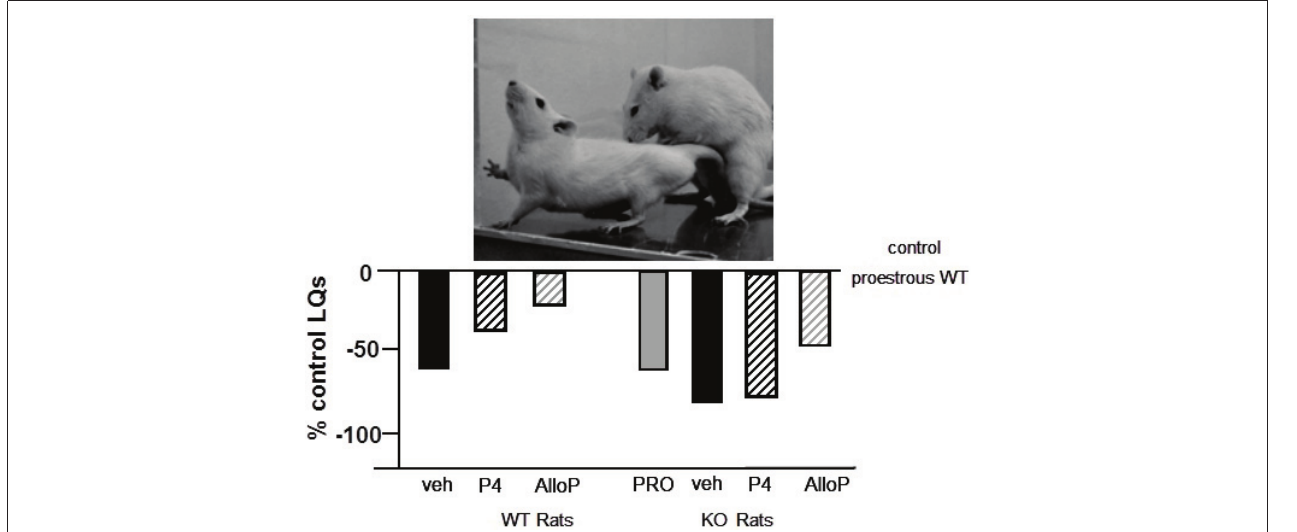
background. This strain of rats is commercially available from SAGE Labs. Data are represented as a percent of the WT proestrous control group. A picture of lordosis is included above the data bars. PXRKO rats have lower lordosis than do WT rats across hormone conditions, with similar improvements in lordosis with replacement back of